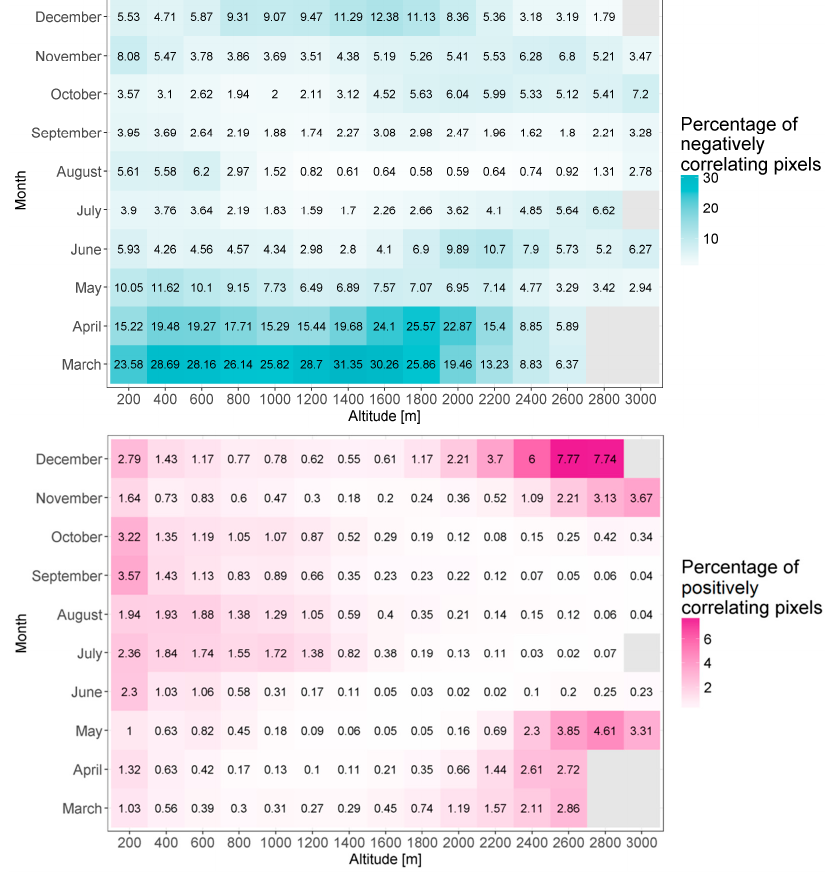
Figure 14 . Tabular overview on the relative amount of significantly negatively ( top ) and positively ( bottom ) correlating pixels of winter SCD (December–February) with all other months’ mean NDVI.